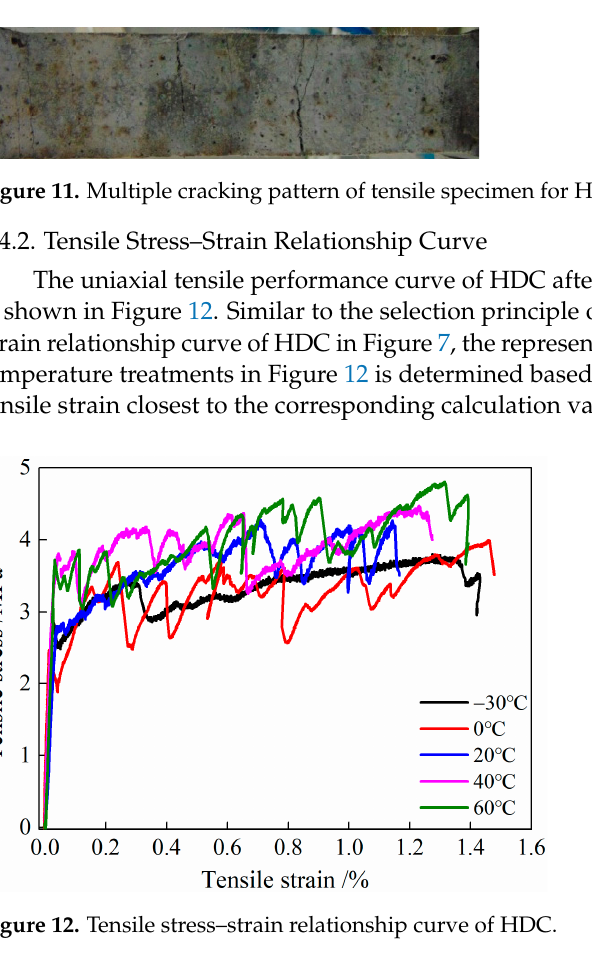
Figure 12. Tensile stress–strain relationship curve of HDC. Table 6. Feature parameters of tensile property for